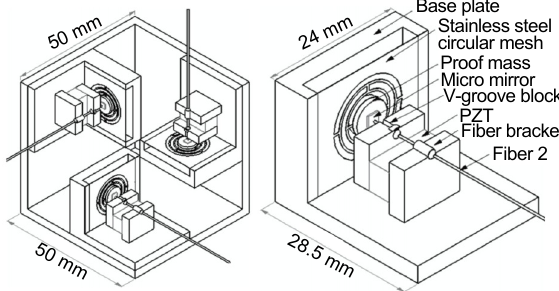
Fig. 21 | Structure of a multidirectional Fabry-Perot cavity based accelerometer. Figure reproduced with permission from ref. 113 , IOP Publishing.